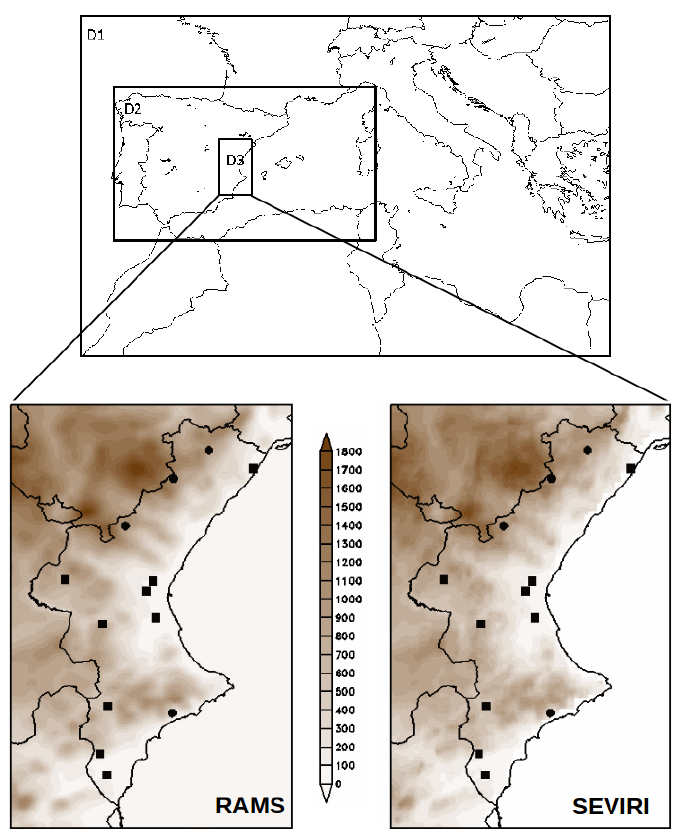
Figure 1. Simulation domain configuration and distribution of the meteorological weather stations used in the validation of solar radiation estimates depending on the terrain class: flat (closed square) and hilly (closed circle) in addition to the orography simulated by Regional Atmospheric Modeling System (RAMS) within the finer domain (D3).